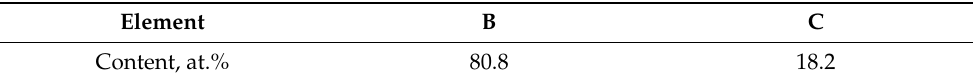
Table 2. EPMA analysis result of the Cu-20 wt.% B 4 C powder (cross mark in Figure 2e). Element B C Content, at.%